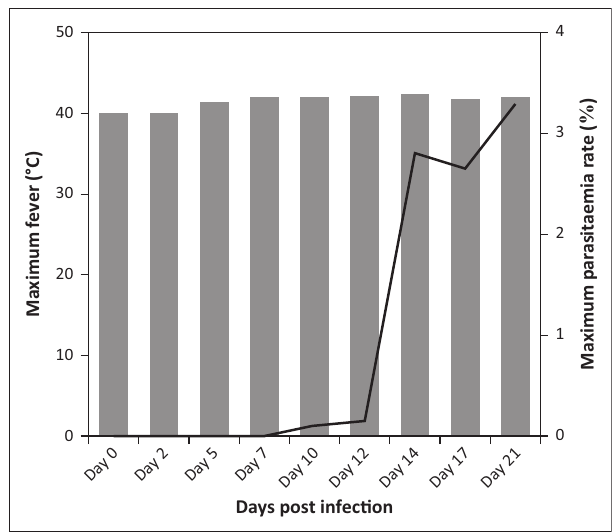
FIGURE 1: Change in body temperature (bar) and percentage of parasitaemia (line) during experimental T. lestoquardi infection in sheep. TABLE 1: The mean levels of cell blood count, cytokine and antibody concentrations in sheep infected with T. lestoquardi during an experimental study. Day Cell blood count Mean ± SD White blood cells (10 3